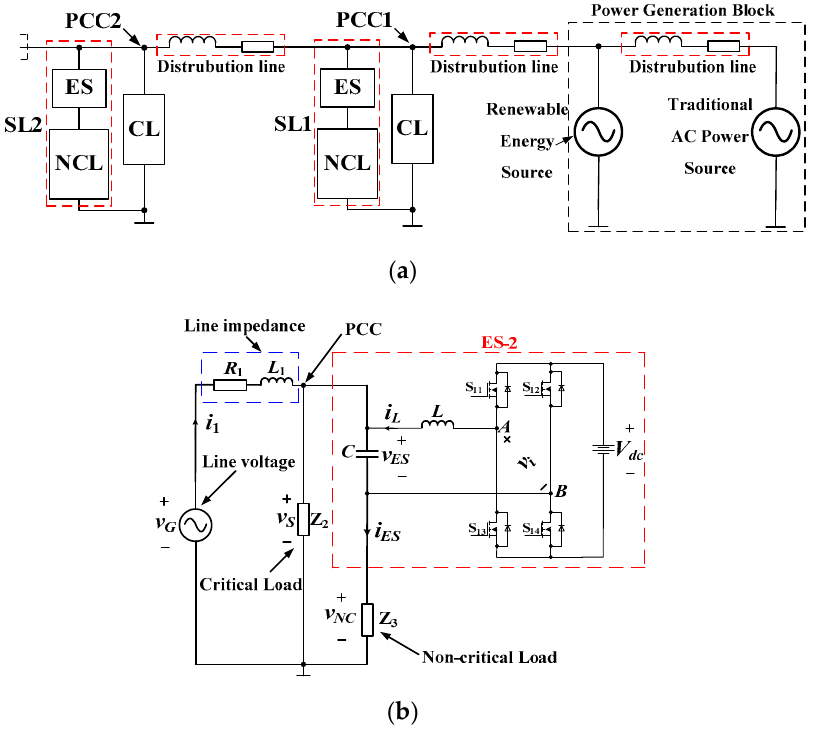
Figure 1. Distribution diagram of single-phase ESs in the power systems. ( a ) Simplified distribution diagram; ( b ) Typical application circuit of an ES.